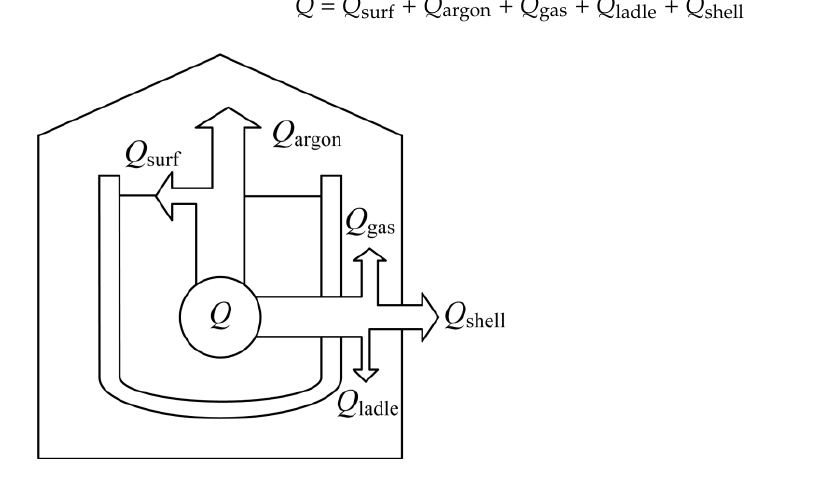
Figure 1. Process flow diagram of VTD.